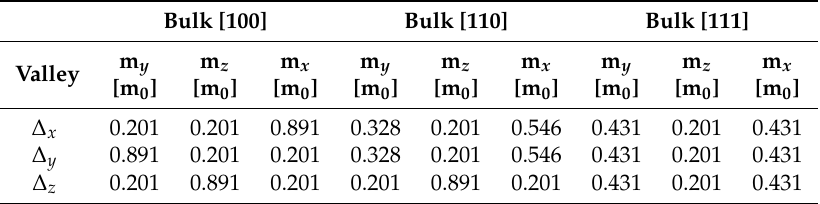
Table 4. Effective masses for Bulk silicon along different crystallographic